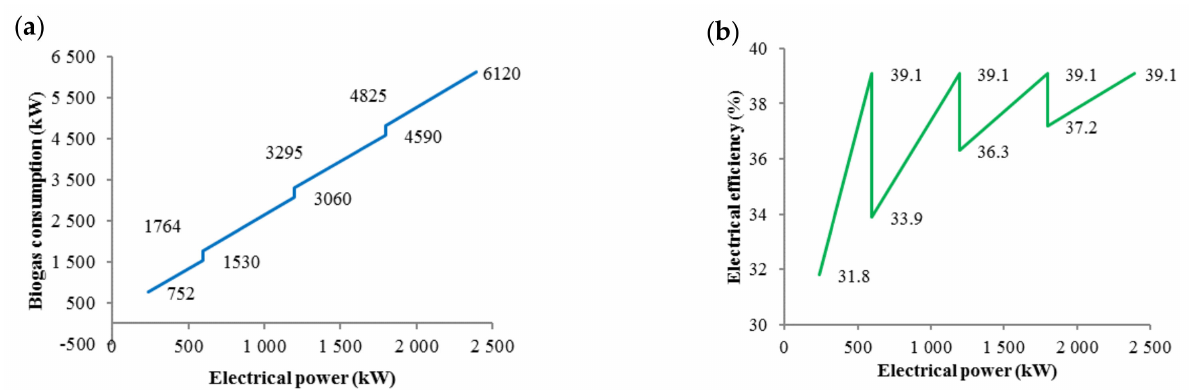
Figure 5. Coupling of the biogas engines, variation of parameters depending on the electrical power generated. ( a ) Biogas consumption; ( b ) Electrical